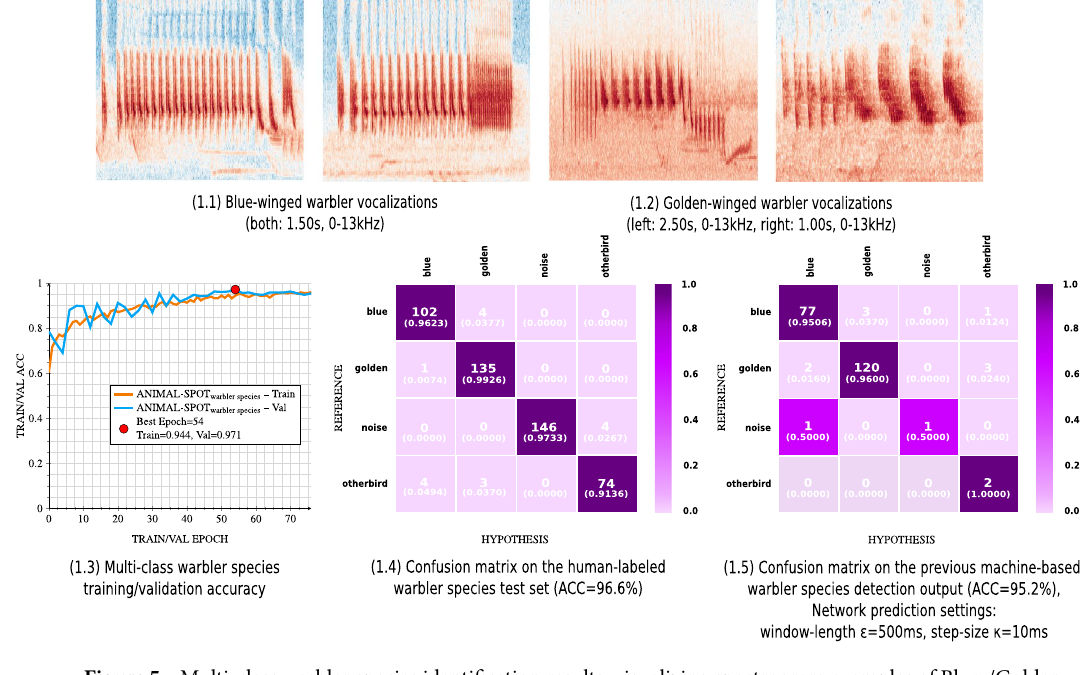
Figure 5. Multi-class warbler species identification results, visualizing spectrogram examples of Blue-/Golden- winged warblers ( 1.1 , 1.2 ), multi-class training/validation accuracy ( 1.3 ), confusion matrix regarding the unseen human-labeled test data ( 1.4 ), as well as confusion matrix concerning previous machine-based warbler detection ( 1.5 ) (created via Inkscape 39 , Version 0.92.3).